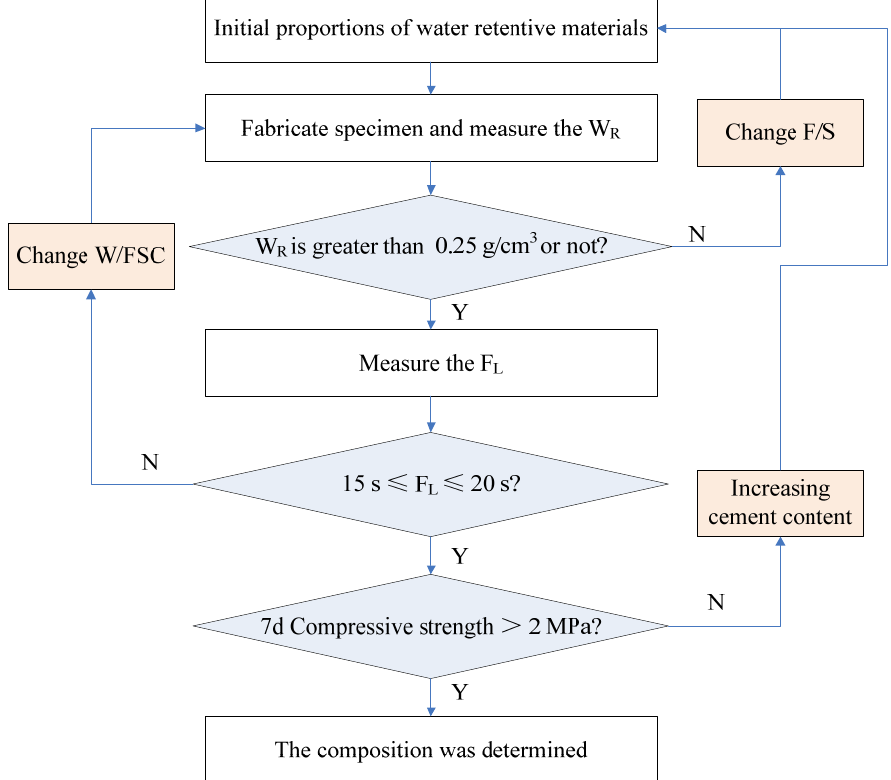
Figure 5. Design procedure of water retentive material.